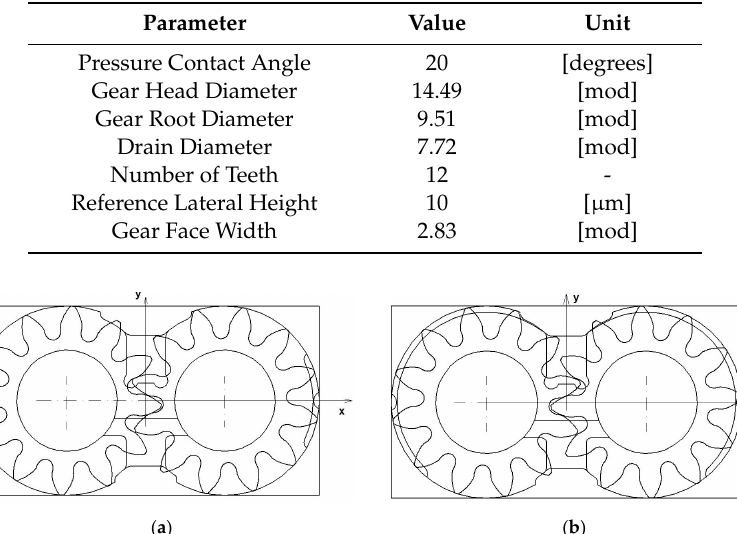
Table 2. Geometrical Parameters Characterizing the Pump.